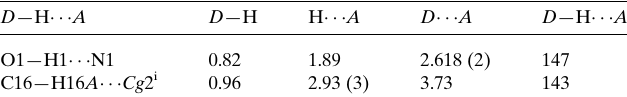
Table 1 Hydrogen-bond geometry (A˚ , (cid:3) ). Cg 2 is the centroid of the C9–C14 ring.